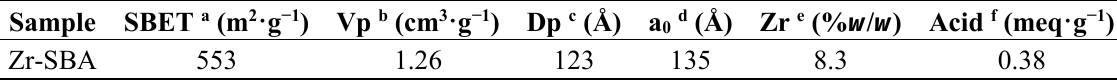
Table 2. Physicochemical properties of Zr-SBA-15